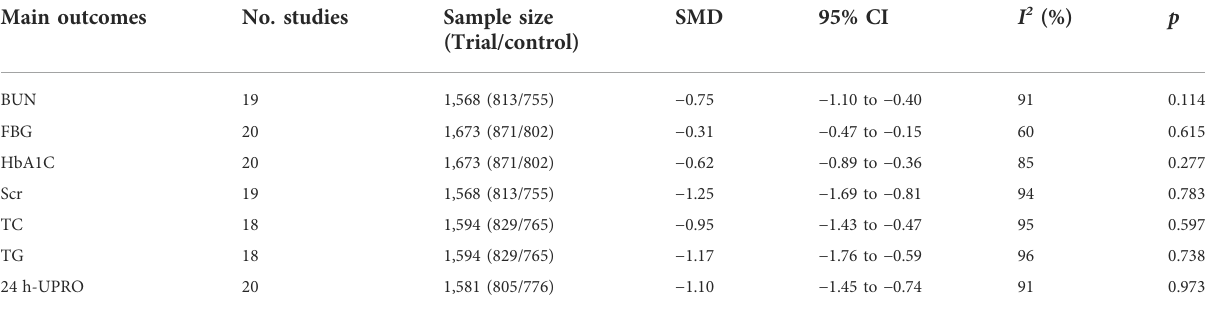
TABLE 2 Summary results of the outcome